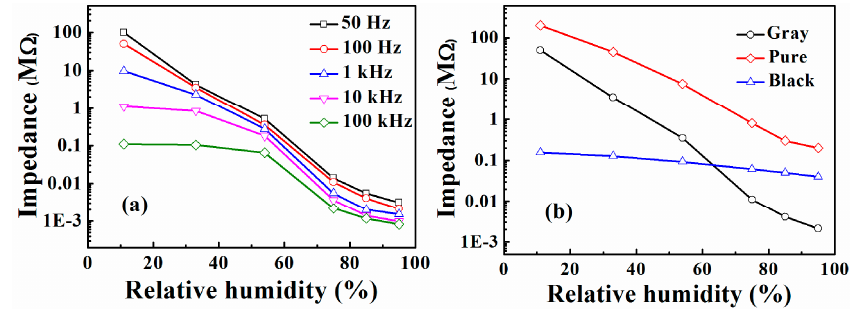
Figure 3. ( a ) Impedance versus relative humidity (RH) curves of TiO 2 /SrTiO 3 humidity sensor at various frequencies; ( b ) The Impedance versus RH curves of sensors based on different samples.